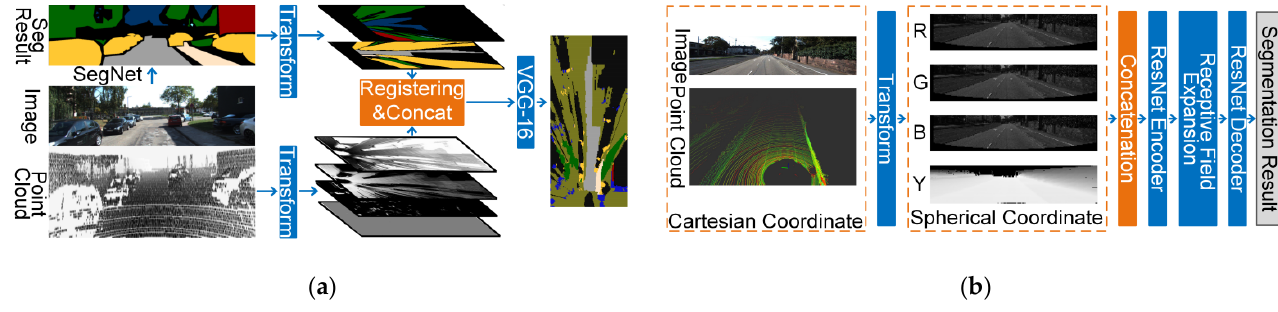
Figure 1. The representative segmentation methods using data-based fusion strategy. ( a ) The structure of the hybrid approach combining the advantages of Bayesian filtering and DNN; ( b ) The spherical coordinate transformation method.